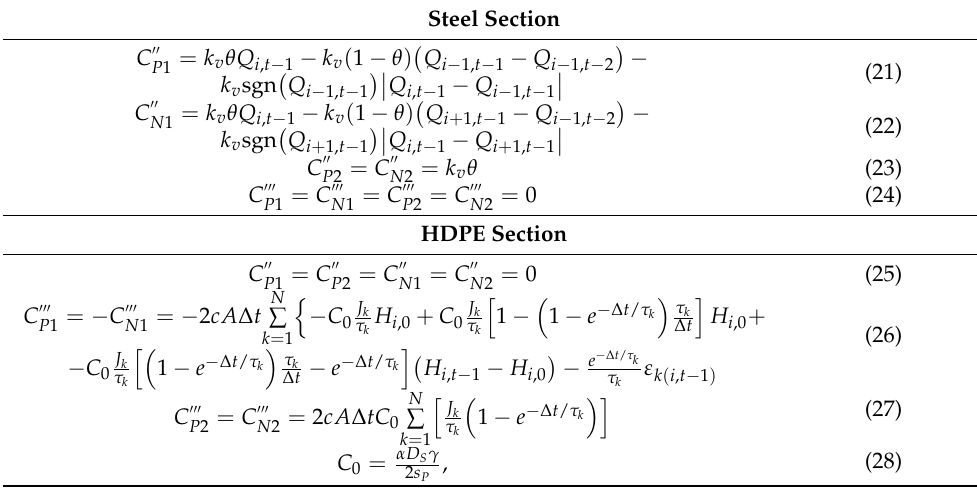
Table 2. Coefficients C N , C a + , C P , and C a − are used to model each section of the pipeline. Steel